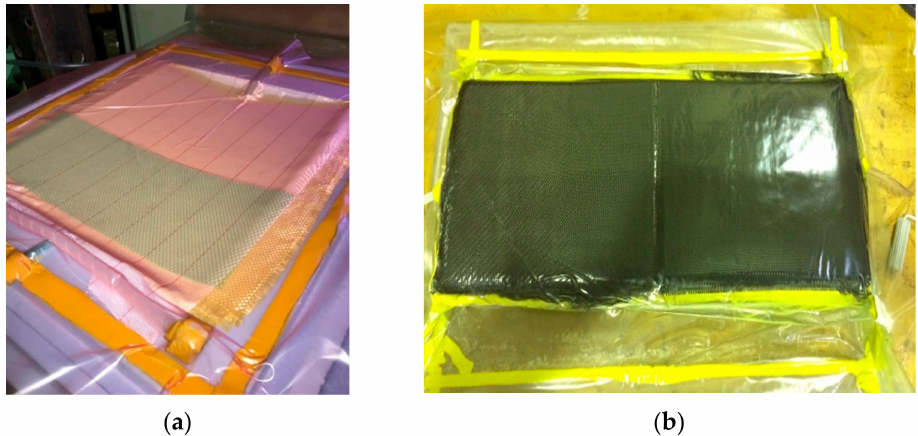
Figure 1. Vacuum infusion fabrication process: ( a ) back-side of the curved non-hybrid [KFRP] 40 plates (plate #1), and ( b ) front-side of the curved hybrid [CFRP 10 /KFRP 30 ] plate (plate